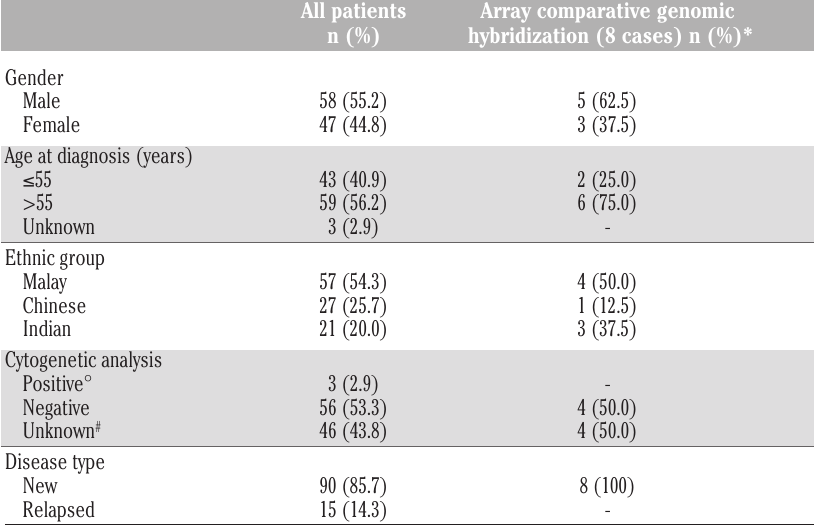
Table 1. Characteristics of 105 multiple myeloma patients diagnosed from